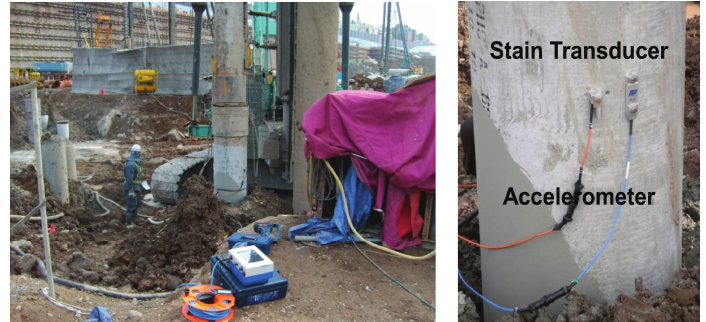
Figure 3: Schematic set-up of dynamic pile loading test.